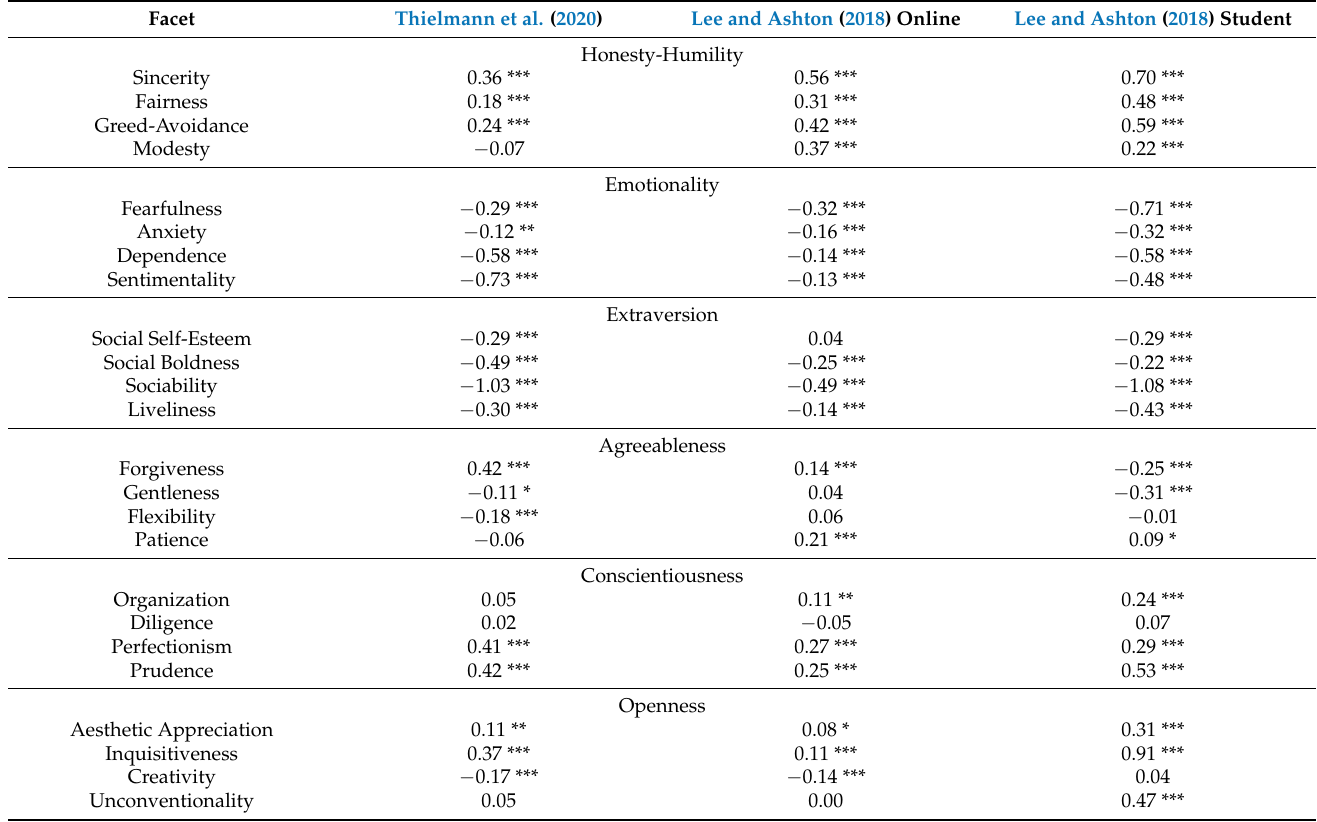
Table 5. Standardized mean differences (Cohen d ’s) for comparisons of HEXACO